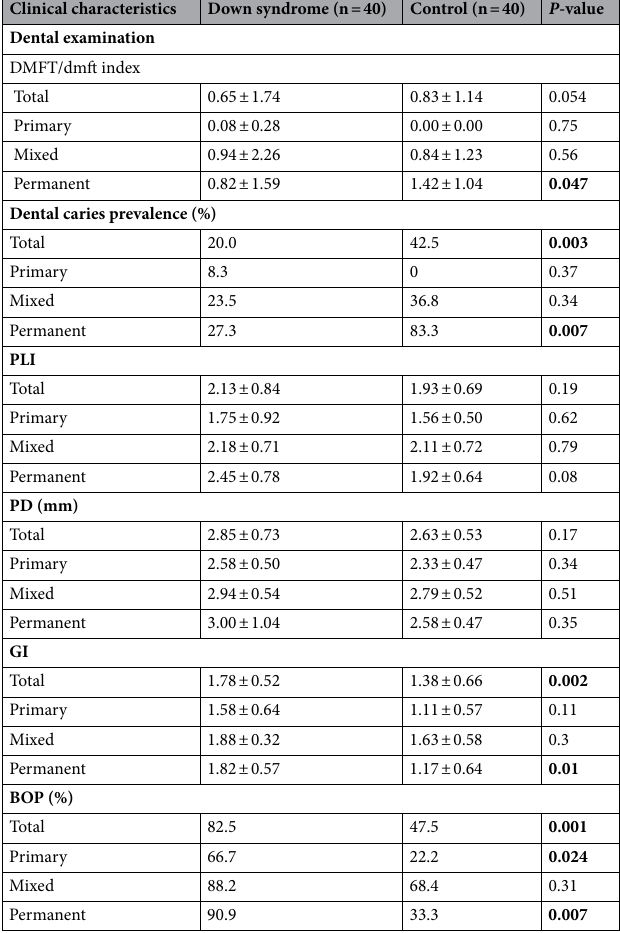
Table 2. Characteristics of study subjects. DMFT/dmft index Decayed, Missing, and Filled Teeth/decayed, missing, and filled teeth index, PLI Plaque Index, PD Probing Depth, GI Gingival Index, BOP Bleeding